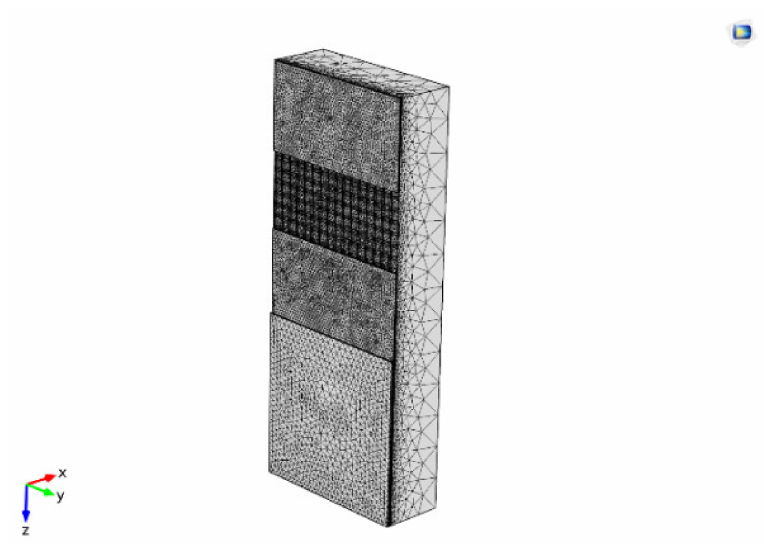
Figure 4. The second model mesh built in Comsol Multiphysics ®